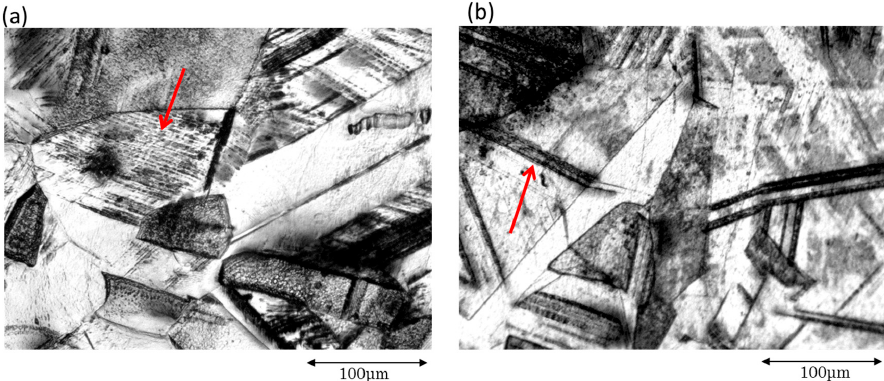
Figure 6. Optical microscope images of SUS304 stainless steels ( a ) after plastic deformation with a stress of 330 MPa (volume fraction: 2.7%) and ( b ) after cooling to 77 K for 5 min without pre-deformation (volume fraction: 9.8%). Dark areas indicate martensite phases, which are colored by small magnetic particles approximately 10 nm in size.